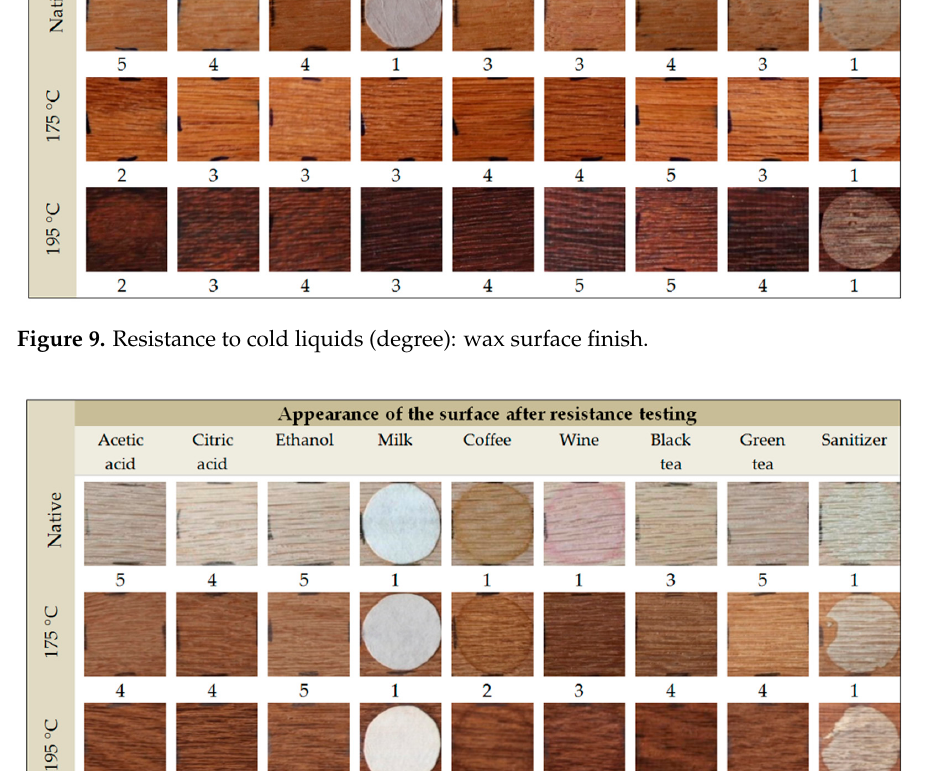
Figure 10. Resistance to cold liquids (degree): uncoated surface of native wood and TMW.